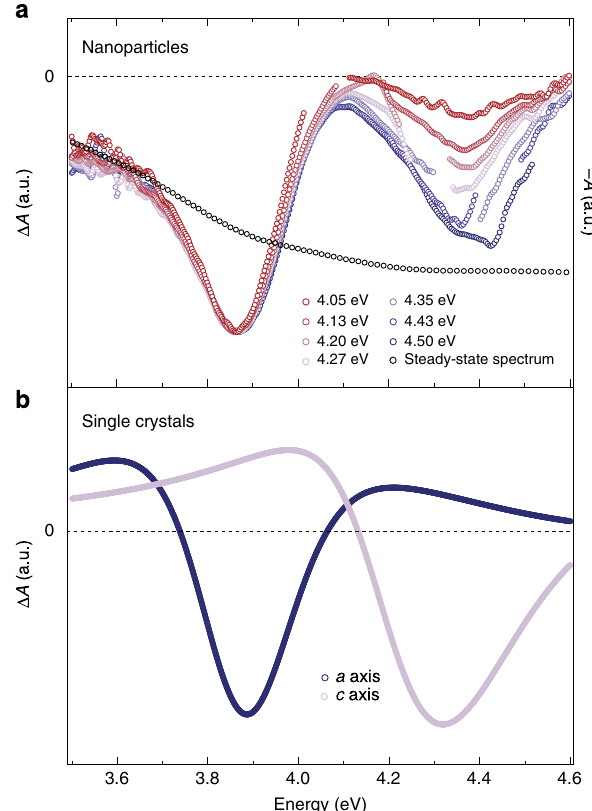
Fig. 8 Ultrafast 2D UV spectroscopy of anatase TiO 2 NPs and single crystals. a Normalised transient absorption ( Δ A ) spectra of RT colloidal solution of anatase TiO 2 NPs at a fi xed time-delay of 1 ps and for different pump photon energies (indicated in the fi gure). Each trace is normalised with respect to the minimum of the main feature at 3.88 eV. For comparison, the black trace shows the inverted steady-state absorption spectrum. b Δ A spectrum of RT anatase TiO 2 single crystals along the a -axis and c-axis at a fi xed time delay of 1 ps. For this experiment, the pump photon energy is 4.40